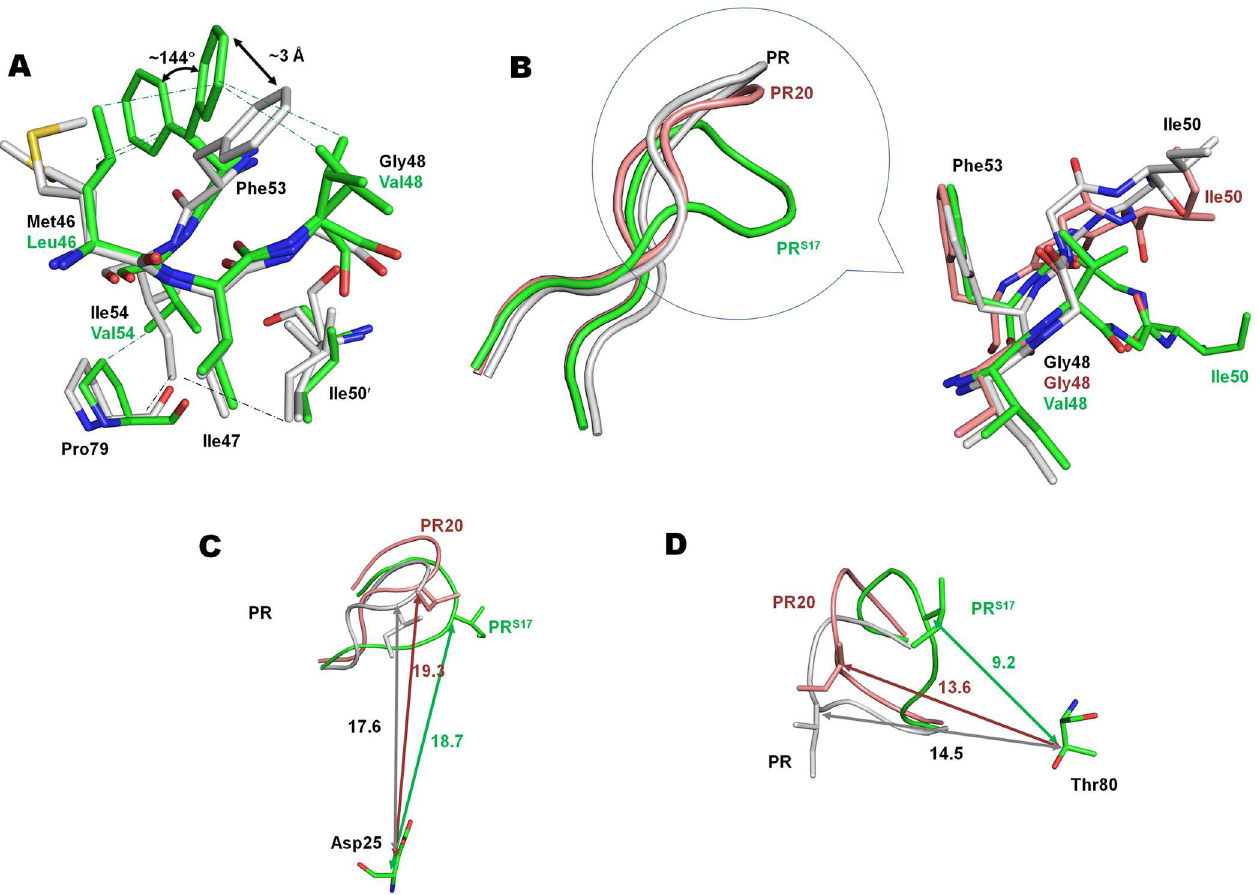
Fig 4. Conformational Changes induced by Flap Mutation Cluster of M46L, G48V and I54V. A. Flap mutation cluster of M46L, G48V and I54V in PR S17 /DRV compared to PR/DRV. B. Curlingof flap due to flap mutation cluster in inhibitor-free structures of PR S17 (green ribbon), PR (grey ribbon)and PR20 (salmonribbon). The conformation of flap tip in the circled portion is shown in sticks for inhibitor-free PR S17 (green carbon), PR (grey carbon) and PR20 (salmoncarbon). C. Distance in ( Å ) between the flap tip residue Ile51 and the catalytic Asp25 in inhibitor-free PR S17 , PR and PR20. D. Distance ( Å ) between the flap tip residue Ile51 and Thr80 in the three inhibitor-free